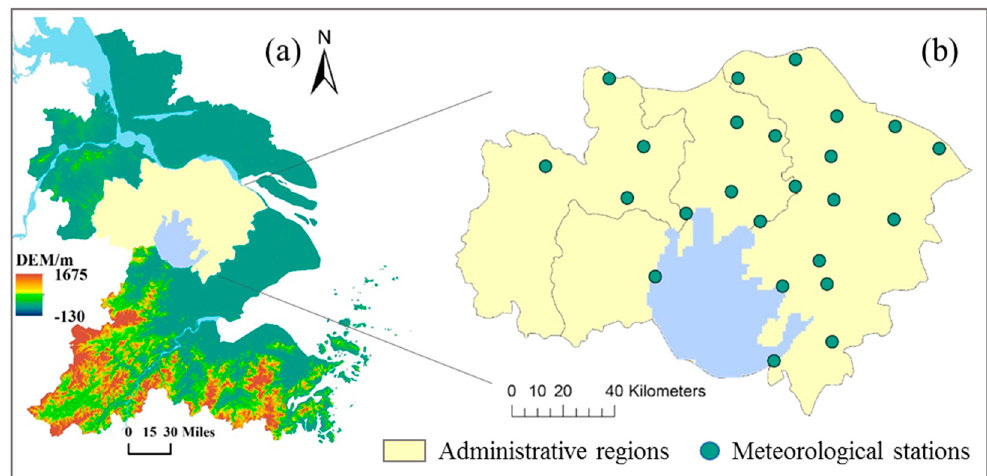
Figure 1. The location of the study region ( a ) and spatial distribution of meteorological stations ( b ).